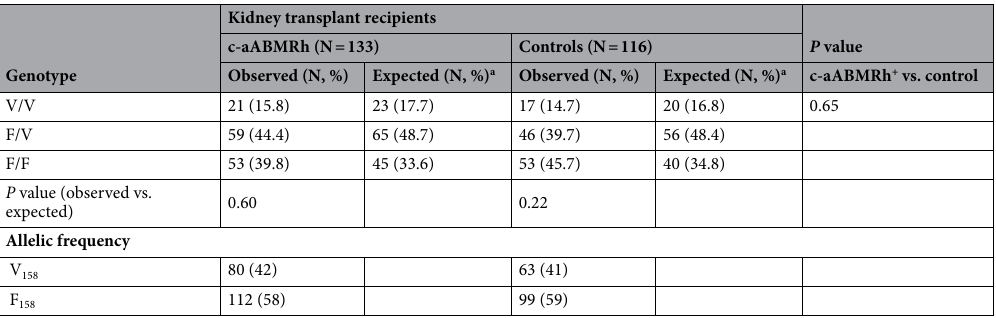
Table 2. FCGR3A 158 F/V-genotype frequencies. a Expected genotype frequencies at Hardy Weinberg equilibrium were calculated from allele frequencies in c-aABMRh and control